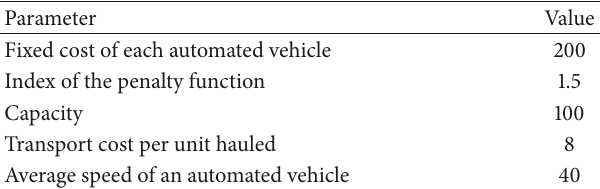
Table 2: Model parameters.